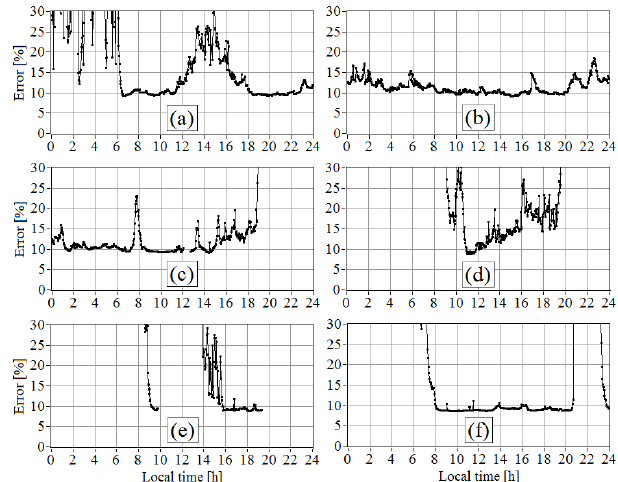
Figure 7. Relative error of estimation of the turbulent energy dis- sipation rate at the mixing layer heights determined from measure- ments on 20 July (a) , 21 July (b) , 22 July (c) , 23 July (d) , 24 July (e) , and 25 July (f) of